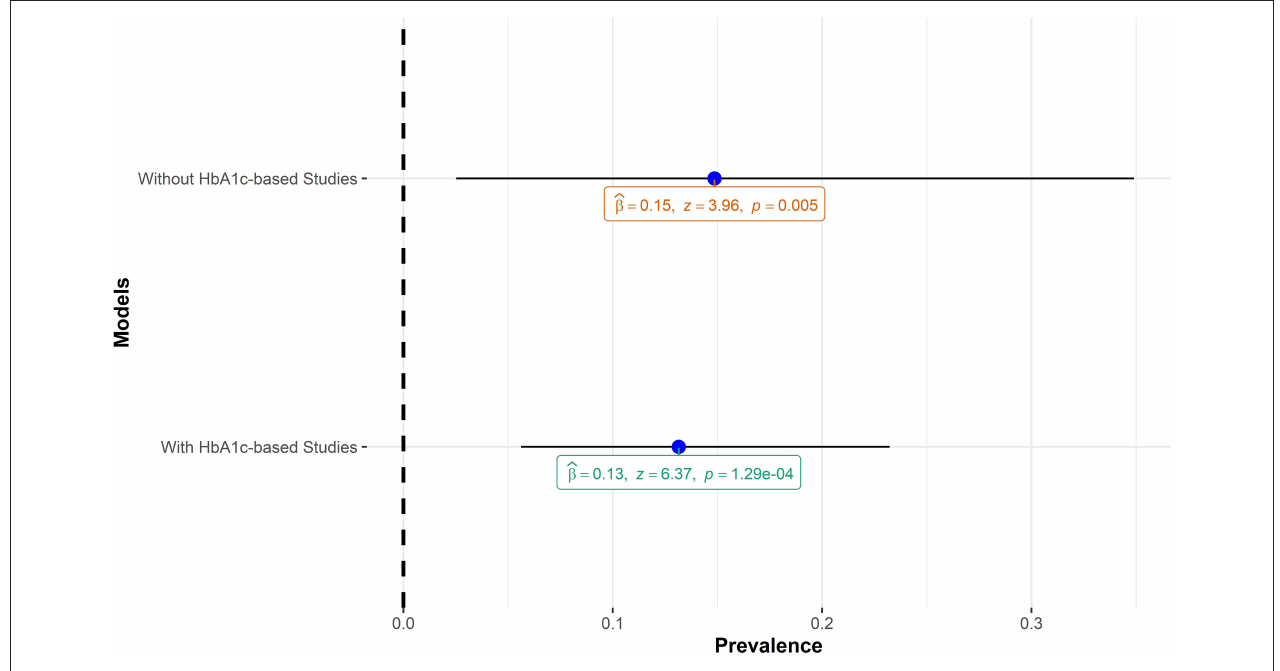
FIGURE 9 | Comparison of pooled prediabetes estimates with and without HbA1c-based studies.